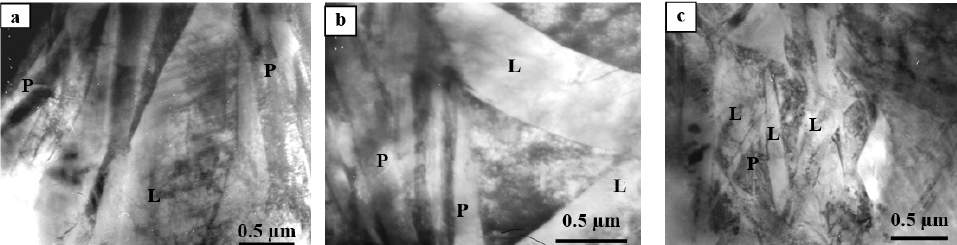
Figure 1. TEM—images of the fine structure of R5M5 steel in the initial state ( α′ -martensite: P—packet martensite, L—lamellar martensite), showing plate martensite, which represents lens-shaped crystals ( a ), crystals grouped in the form of “zigzags” ( b ), small packets of slats in the steel, which are located in areas of grain with small martensitic plates ( c ). The initial state α′ -martensite: P—packet martensite, L—lamellar martensite.